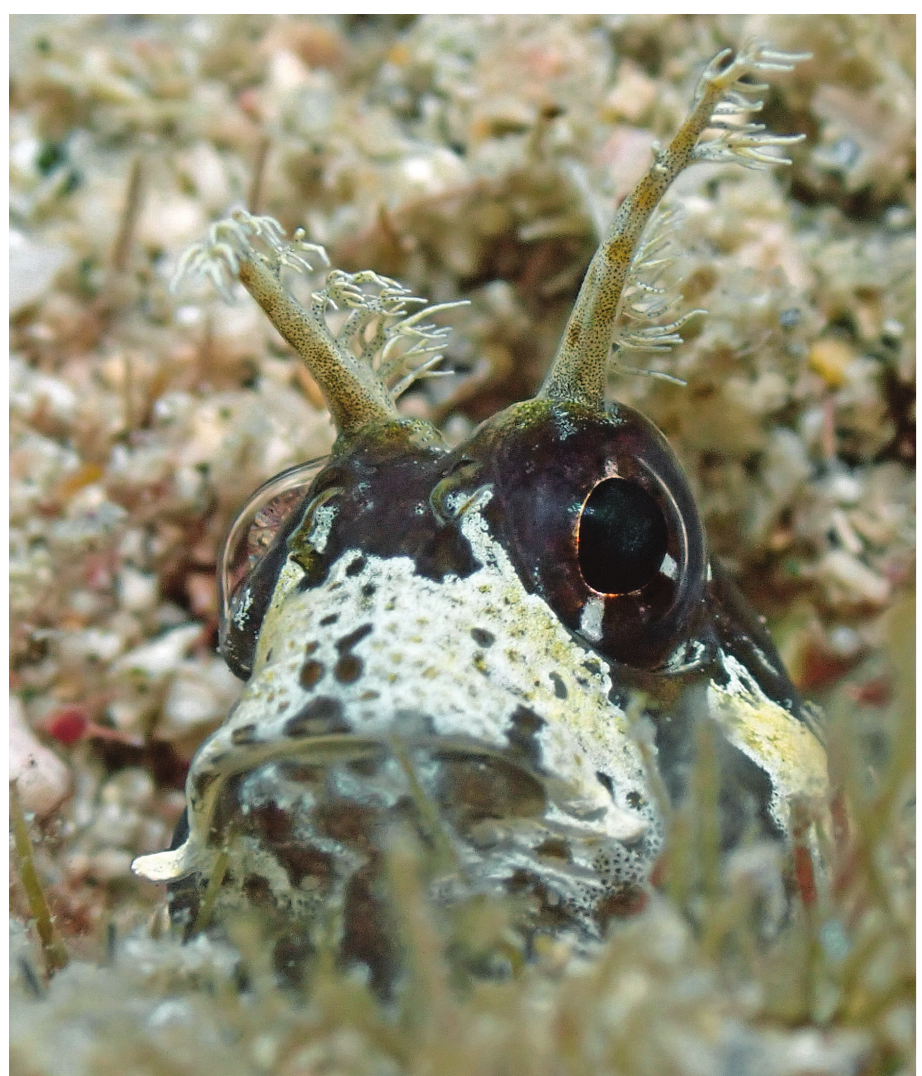
Figure 1. Hypsoblennius exstochilus . Photo: Natasha Bestrom (natasha.bestrom@uvi.edu) St Thomas, US Virgin